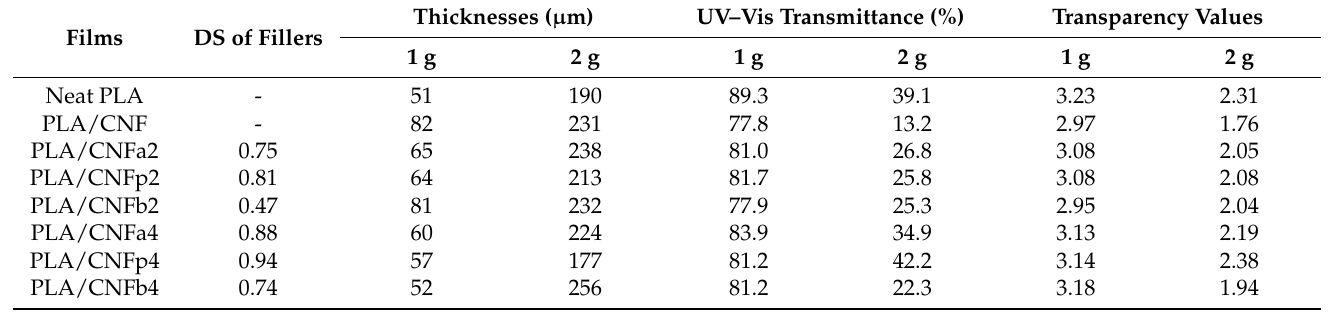
Table 2. Average thickness, transmittance, and transparency values of the PLA/m-CNF composite films.